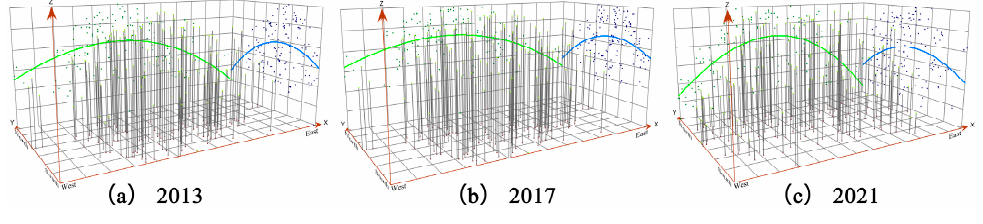
Figure 4. Trend analysis of LCI.